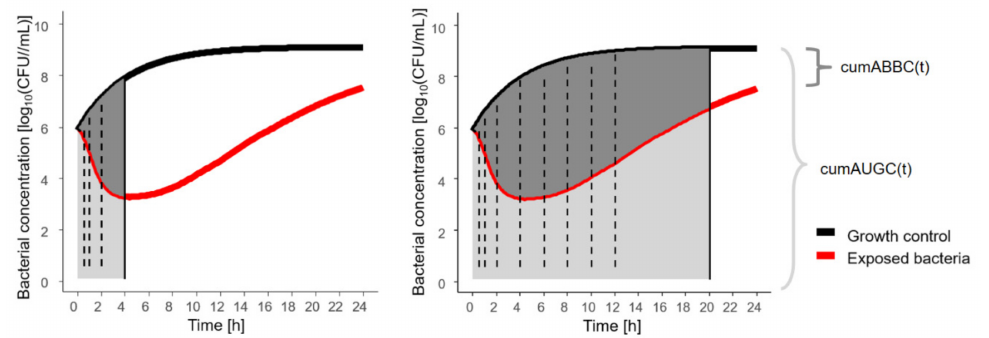
Figure 4. Illustration of novel pharmacodynamic metric, cumABBC(t), to quantify the antibiotic effect based on in vitro infection model experiments, exemplified for two sampling time points at 4 h ( left ) with cumABBC(4 h), and at 20 h ( right ) with cumABBC(20 h); solid vertical line: sampling time point of assessment; dashed vertical lines: intermediate sampling time points; cumABBC(t): cumulative area between growth-control and bacterial-killing and -regrowth curve as function of time (dark grey area); cumAUGC(t): cumulative area under the growth-control curve as function of time (sum of light + dark grey